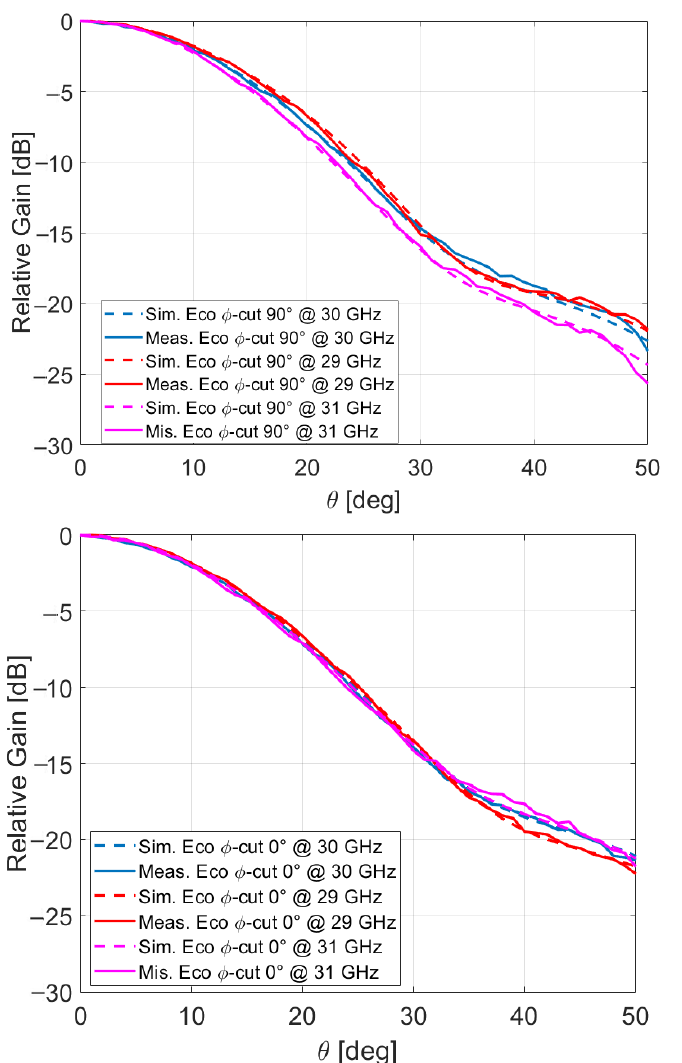
Figure 5. Measured and simulated radiation patterns of the optimized horn in the E ( top ) and H ( bottom ) planes at three different frequencies in the considered